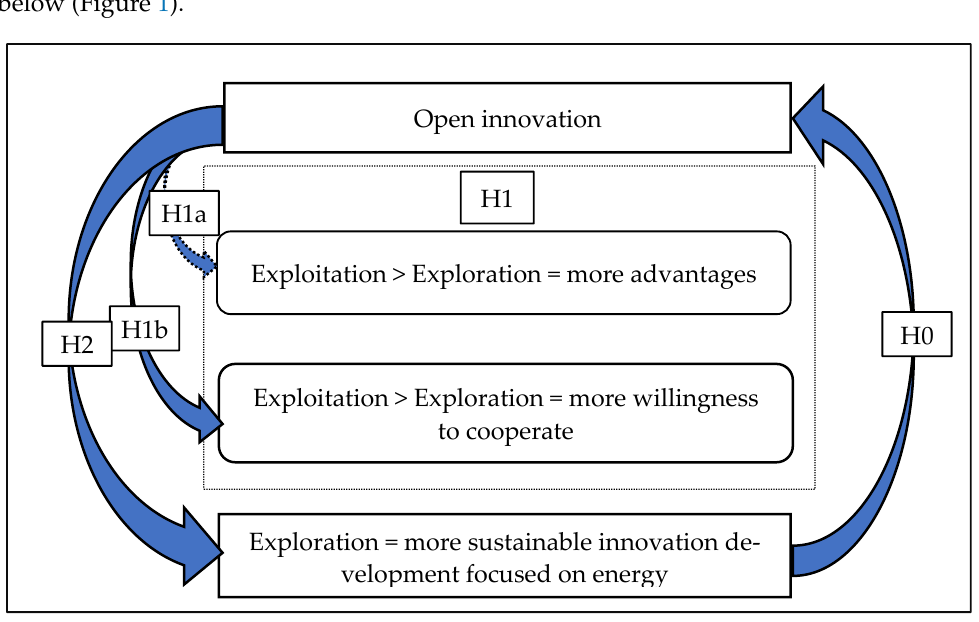
Figure 1. Research model — the relationship between OI and sustainable innovative development.